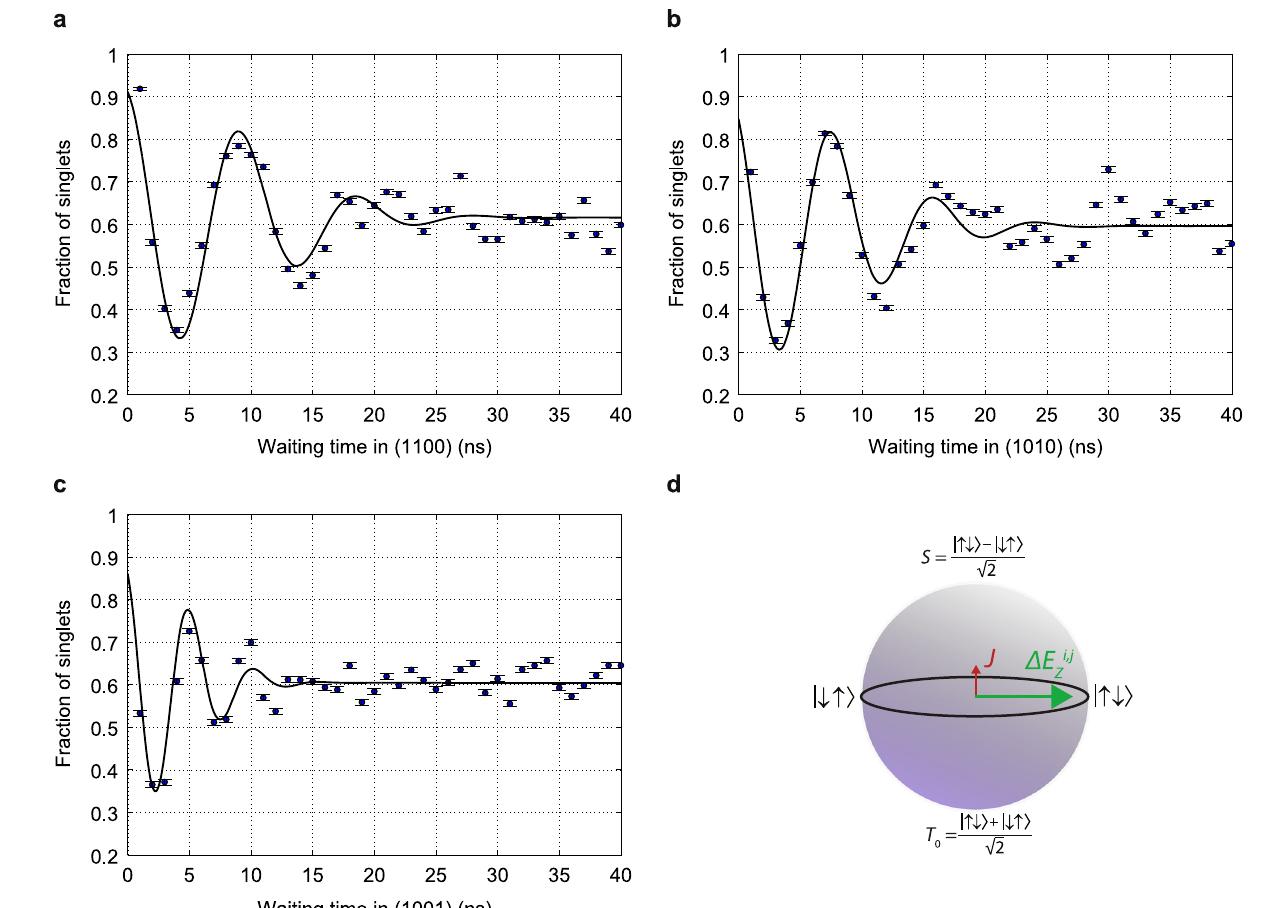
Fig. 3 Coherent shuttling and S - T 0 oscillations. a – c Measured spin-singlet probability as a function of the waiting time in the (1100), (1010), or (1001) charge state (error bars indicate 95% con fi dence intervals). This waiting time occurs in between separating the electrons and trying to bring them back together. The spin-singlet probability is fi tted with a Gaussian damped cosine function with a constant phase shift. The fi tted S - T 0 oscillation frequencies are: 103 ± 5, 118 ± 7, and 185 ± 14 MHz respectively. The fi tted contrasts are 0.63 ± 0.12, 0.62 ± 0.14, and 0.57 ± 0.15. The damping is attributed to the random nuclear fi elds in the two dots and the phase shift accounts for the additional shuttle towards the measurement point. d Bloch sphere representation of a singlet-triplet qubit. For a spin singlet distributed over two separated dots, the , exchange interaction J is small and the Zeeman energy difference between the dots, Δ E i ; j z